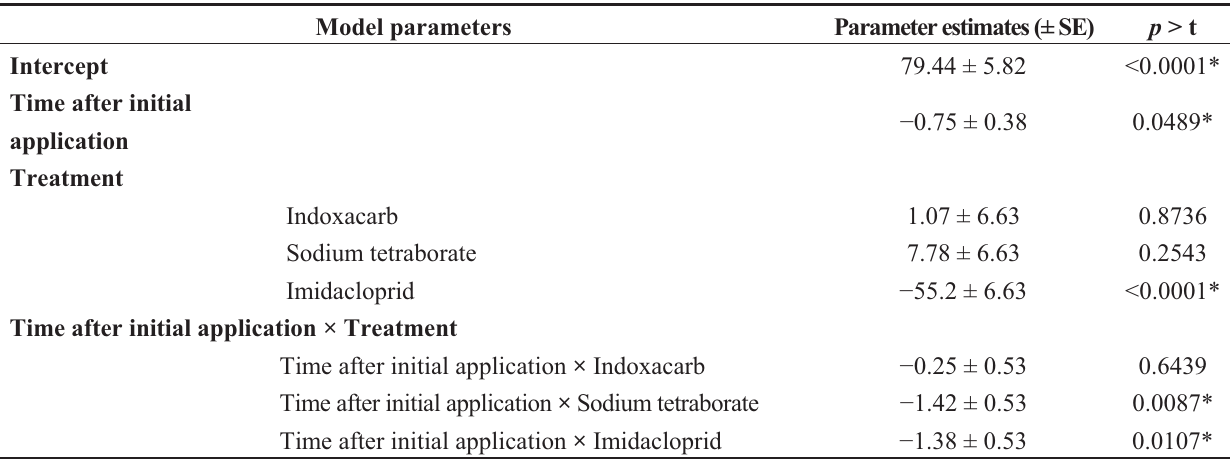
Table 4. Results of multiple regression analysis on the percentage dark rover ant mortality as a result of exposure to different bait treatments. Parameter estimates represent deviations from the results obtained from the control